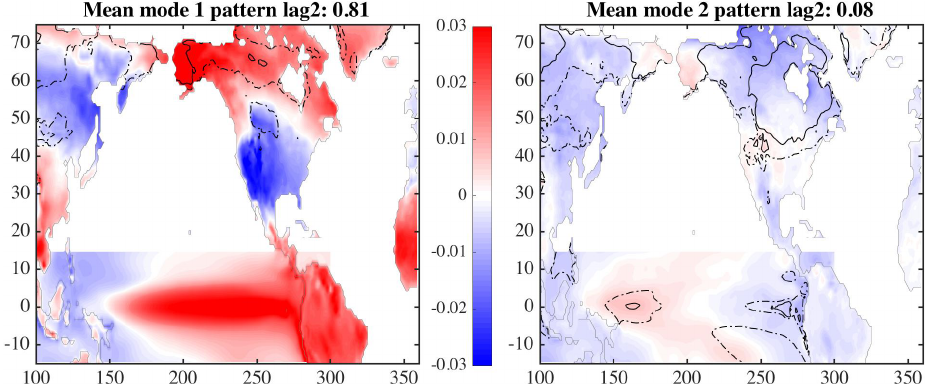
Figure 10. Same as Fig. 6, except for representing the covariance between the tropical Pacific 25m ocean temperatures and surface land temperatures at a lag of 2